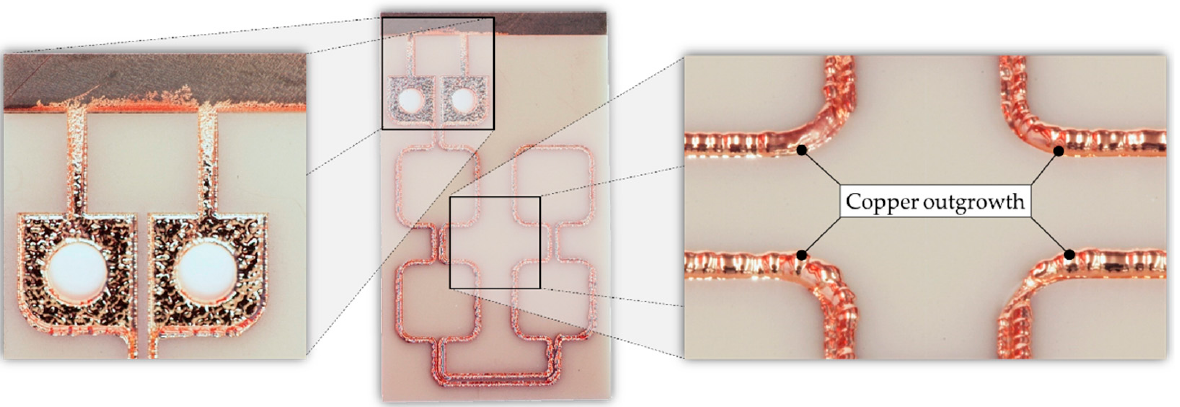
Figure 10. Photographic images of the AlN carrier after ECD process with copper filled trenches.